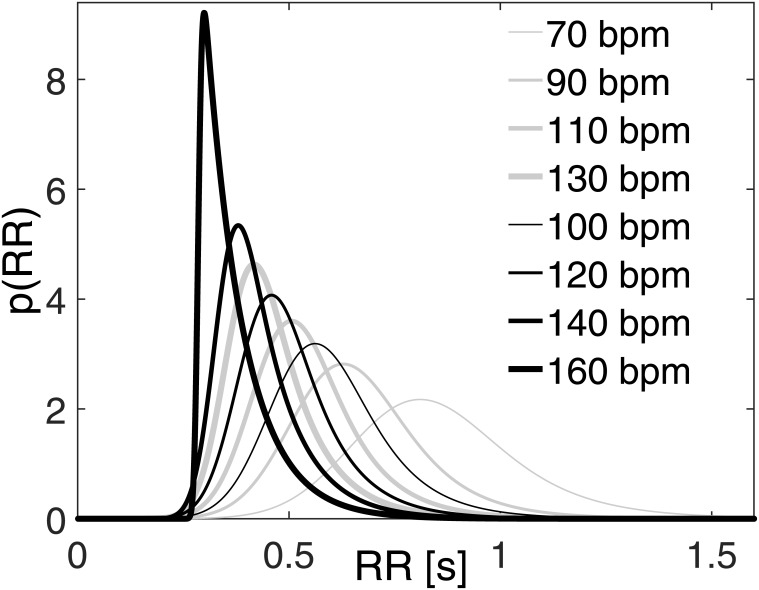
Probability distribution functions of the RR beating for the different AF simulations.Mean, μ, standard deviation, σ, and rate parameter, γ, values of each configuration are reported in Table 3.